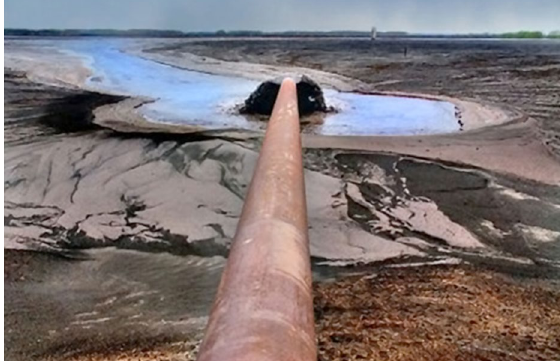
Fig. 3. The look of fly ash and slag landfill and devastated environment (the pipeline length is approximately 6.5 km from the thermal power plant Kostolac to the ash pond)